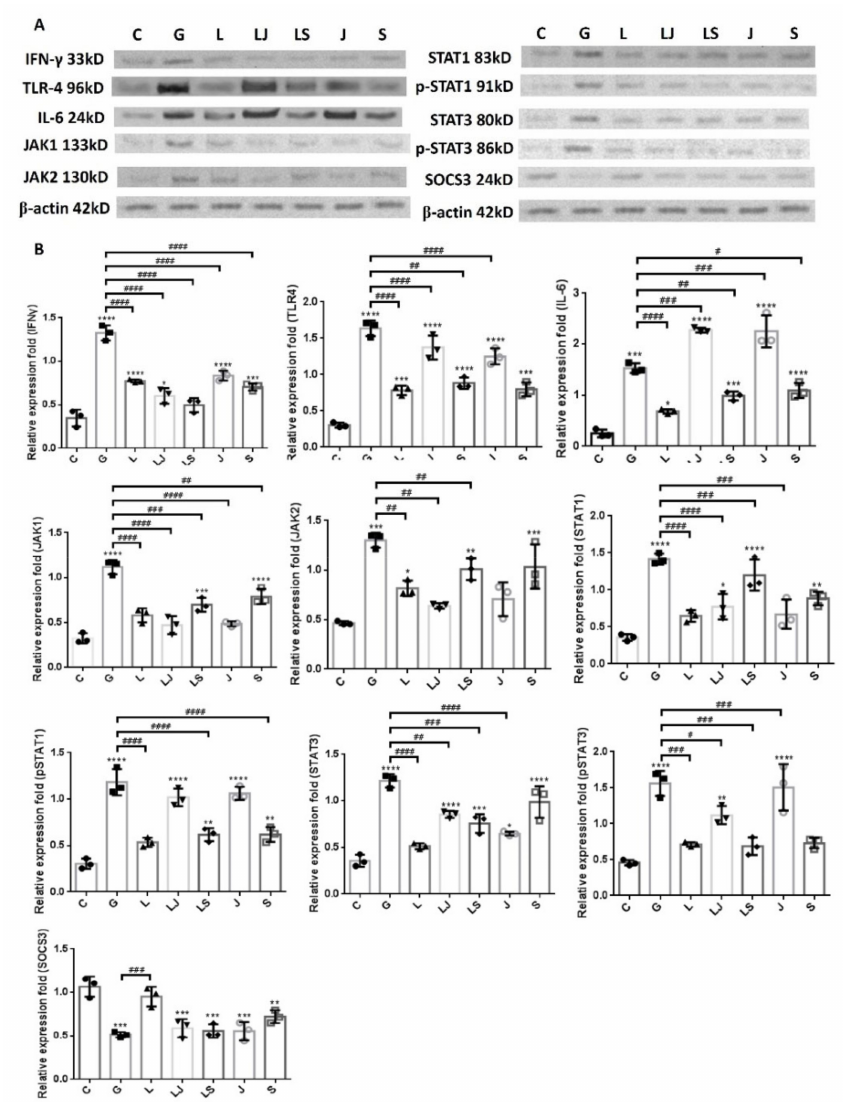
Figure 8. JAK and STAT inhibitors affected the LCN2-downregulated JAK/STAT pathway and inflammatory factors in UPEC-infected bladder cells in a high-glucose environment. SV-HUC-1 cells were pretreated with a 25 µ M JAK inhibitor (LJ) or 50 µ M STAT inhibitor (LS) and 15 mM glucose for 24 h before a 25 µ g/mL LCN2 pretreatment followed by UPEC infection (MOI of 100), as described above. Cells pretreated with the 25 µ M JAK inhibitor (J) or STAT inhibitor (S) alone for 24 h followed by UPEC infection were used as respective controls. Cells pretreated with 25 µ g/mL LCN2 alone (L) followed by UPEC infection were used as other controls. Cells infected with 15 mM glucose and UPEC alone were used as the respective positive controls (G). The picture shown is representative of a typical result. The total protein from all cell groups was collected for detection. ( A ) The total protein expression of JAK1, JAK2, STAT1, STAT3, phosphorylated-STAT1/STAT3, the inhibitor SOCS3, TLR4, IL-6, and IFN- γ were analyzed using Western blotting. ( B ) All data were normalized by their own internal reference, β -actin. The results were assessed using a densitometer and quantified using ImageJ software (NIH). The results are presented as means ± SDs of three independent experiments. * p < 0.05, ** p < 0.01, *** p < 0.001, **** p <0.0001 compared to the respective control groups. An analysis of variance was used to evaluate differences between various treatment groups and controls. Statistical differences between groups were determined using the Mann–Whitney U Student’s t -test. Statistical significance was set at p < 0.05. # p < 0.05, ## p < 0.01, ### p < 0.001, #### p <0.0001 for comparisons between the two individual